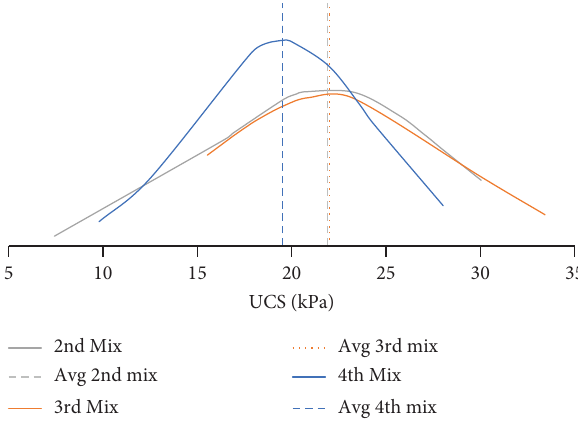
Figure 9: Probability distribution curve of the UCS test result in the second phase.